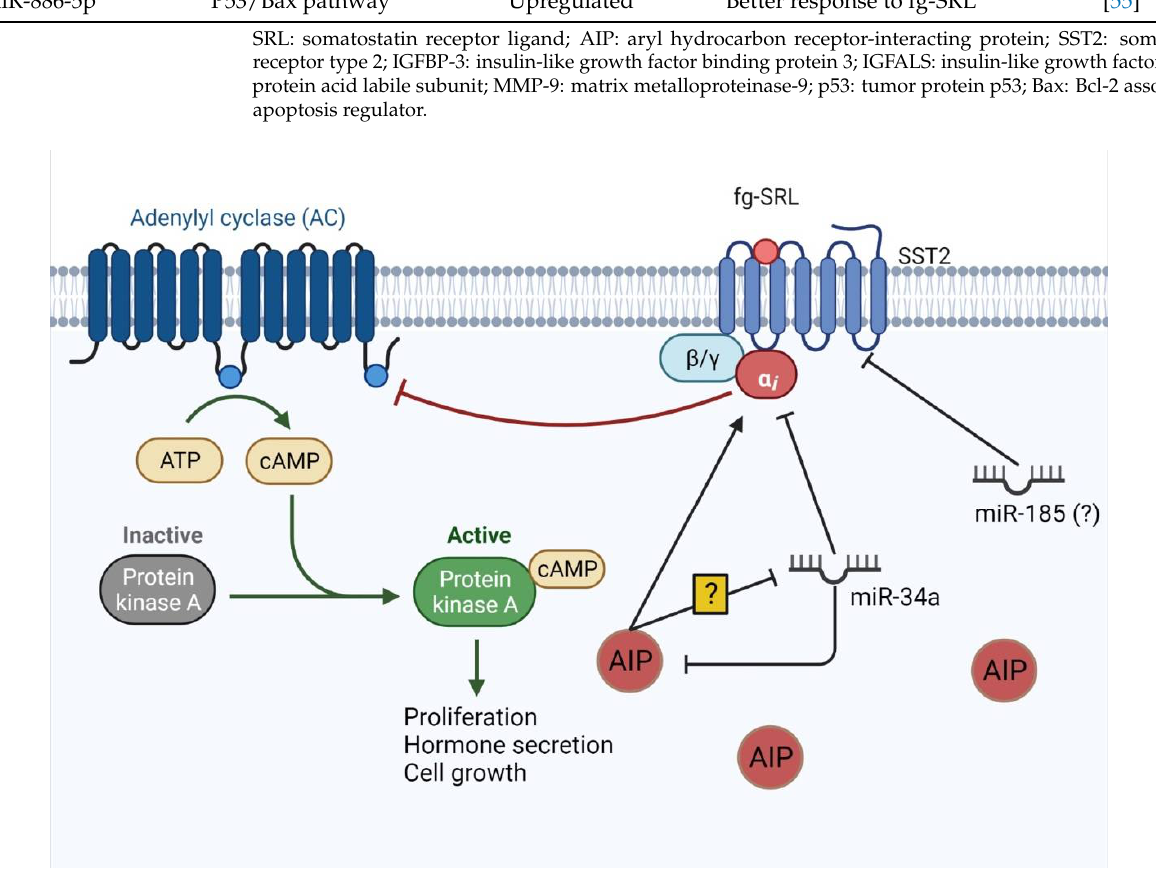
Figure 3. miRNAs involved in SST2 signaling. SST2 acts to inhibit adenylyl cyclase (AC) through inhibitory G protein. AIP also stimulates this inhibition. AC turns ATP into cyclic AMP (cAMP), which activates protein kinase A (PKA) that, through its pathway, leads to cell proliferation, growth, and hormone secretion. miR-34a targets AIP and G inhibitory a subunit and it is also inhibited by AIP by unknown mechanisms. miR-185 directly targets SST2 mRNA and might play a role in decreasing SST2 levels. Figure adapted from “Activation of Protein Kinase A (PKA)”, by BioRender.com (2022). Retrieved from